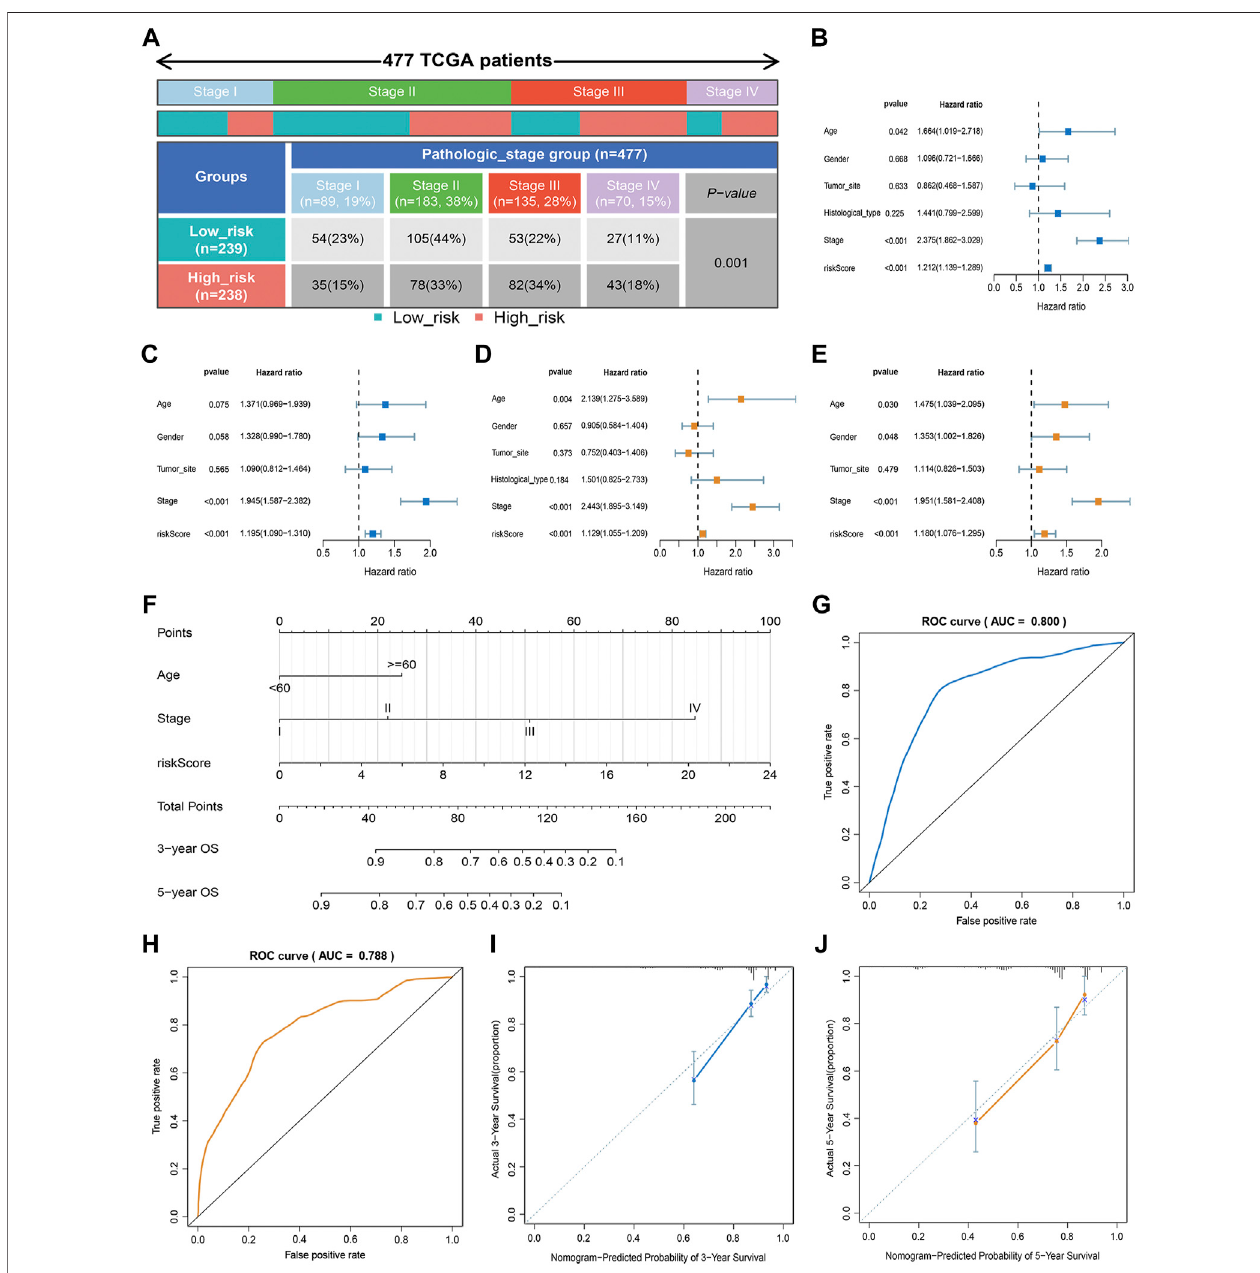
FIGURE3| Clinicalvalueoftheriskscore. (A) AssociationofriskscorewithTNMstage. (B,C) Univariateanalysisofriskscoresand clinicopathological parameters in the training (B) and GSE39582 cohort (C) . (D,E) Multivariate Cox regression analysis of risk scores and clinicopathological parameters in the training (D) and GSE39582 cohort (E) . (F) Prediction of the nomogram based on clinical traits and risk score. (G,H) ROC curves of the nomogram for OS prediction at three (G) and 5 years (H) . (I,J) Calibration curve of the nomogram for predicting OS rates at three (I) and 5 years (J) .